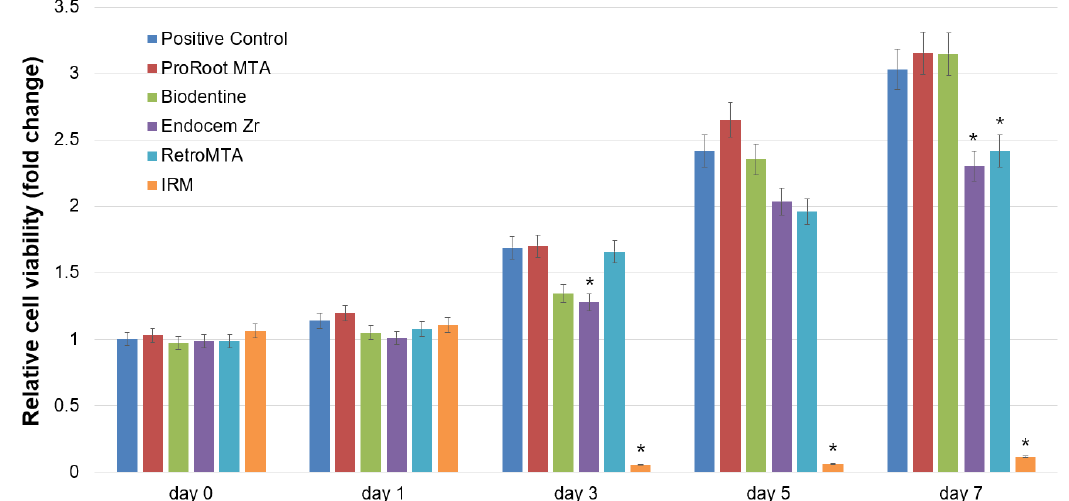
Figure 1. Relative cell viability based on methyl-thiazoldiphenyl-tetrazolium (MTT) assay. Asterisks represent statistically significant differences between the positive control and experimental groups.